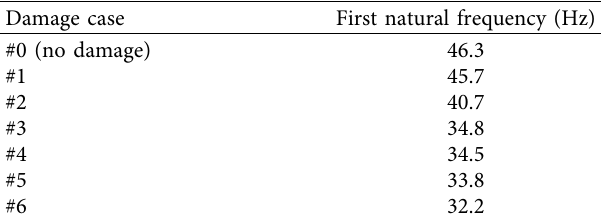
Table 7: First natural frequency by damage